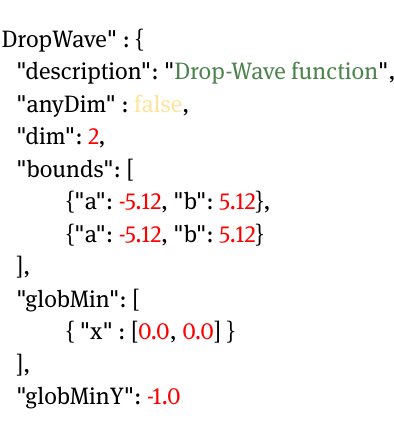
} Figure 4: The meta description of the DropWave function in JSON